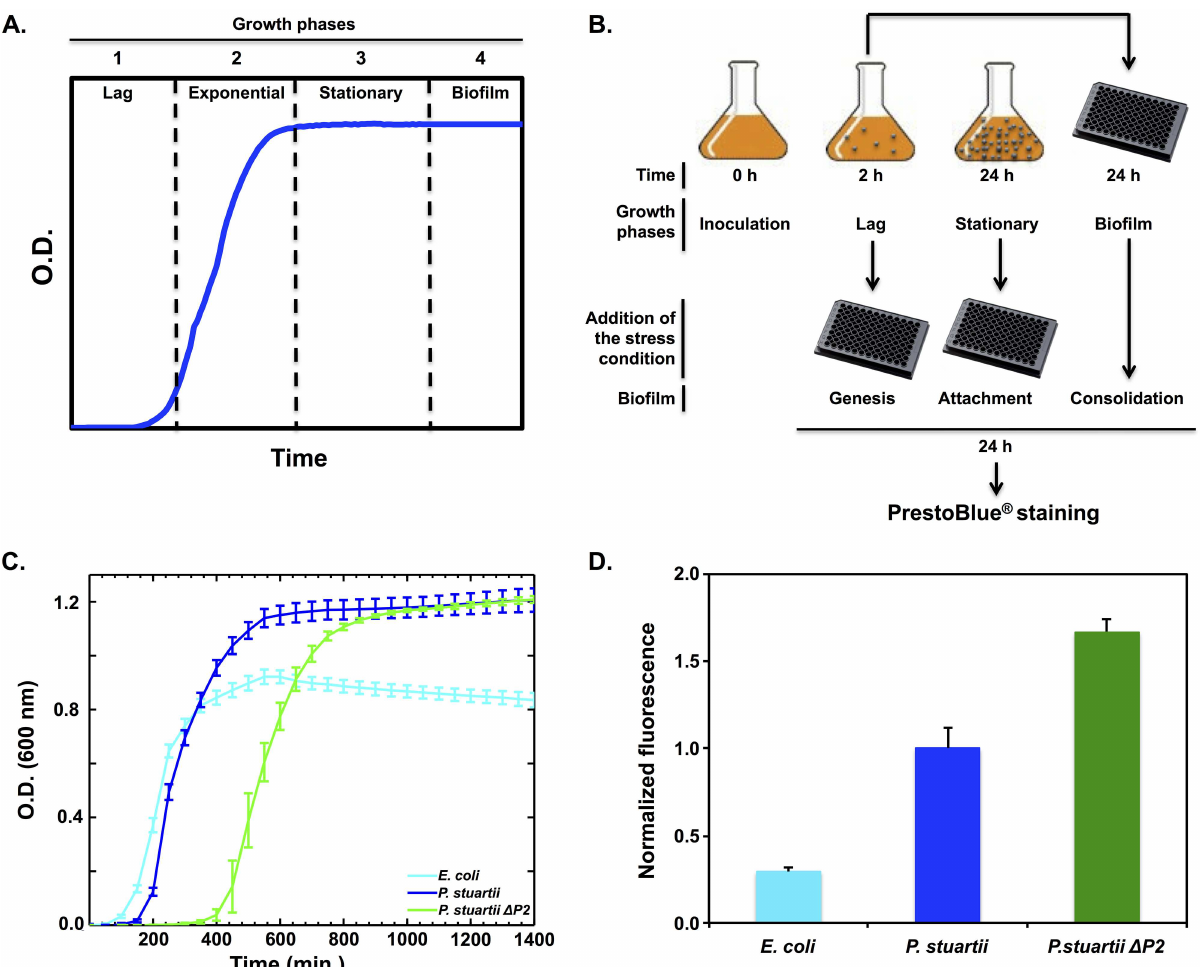
Fig 1. Planktonic bacterial growth and biofilm formation. (A) Bacterial growth can be dividedinto 4 main phases: (1) the lag phase, (2) the exponential phase, (3) the stationary phase and (4) the biofilm establishment phase. (B) Growth curves of E . coli BL21, P . stuartii and P . stuartii- Δ P2. (C) Experimental protocol designed to challengethe effect of various environmental stresses on the different stages of biofilm formation (genesis, attachment, consolidation) by P . stuartii . (D) Biofilm quantification after 24h of growth in 96-wellsplates, as revealedby of adherentcells using PrestoBlue. Data are normalized with respect to measurements performed on P . stuartii .